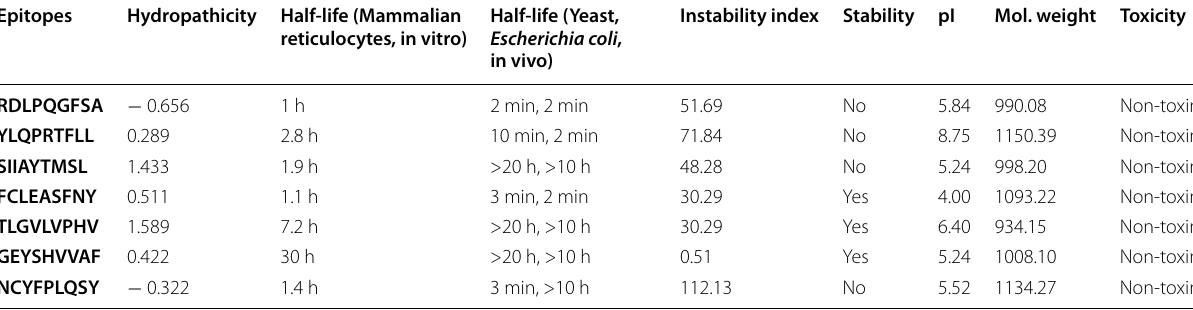
Table 2 Toxicity and physicochemical properties of the candidate epitopes Epitopes